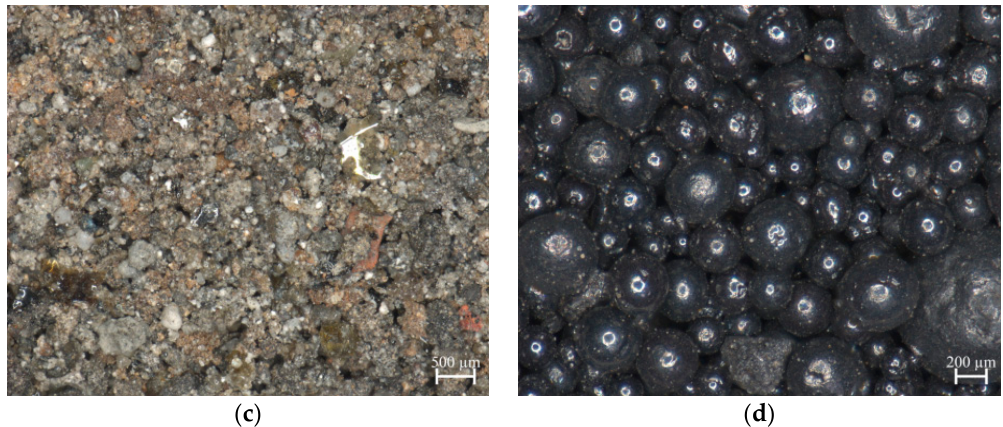
Figure 3. Images of fillers: ( a ) coal ash (CA) I, ( b ) CA II, ( c ) CA III and ( d ) slag aggregates.